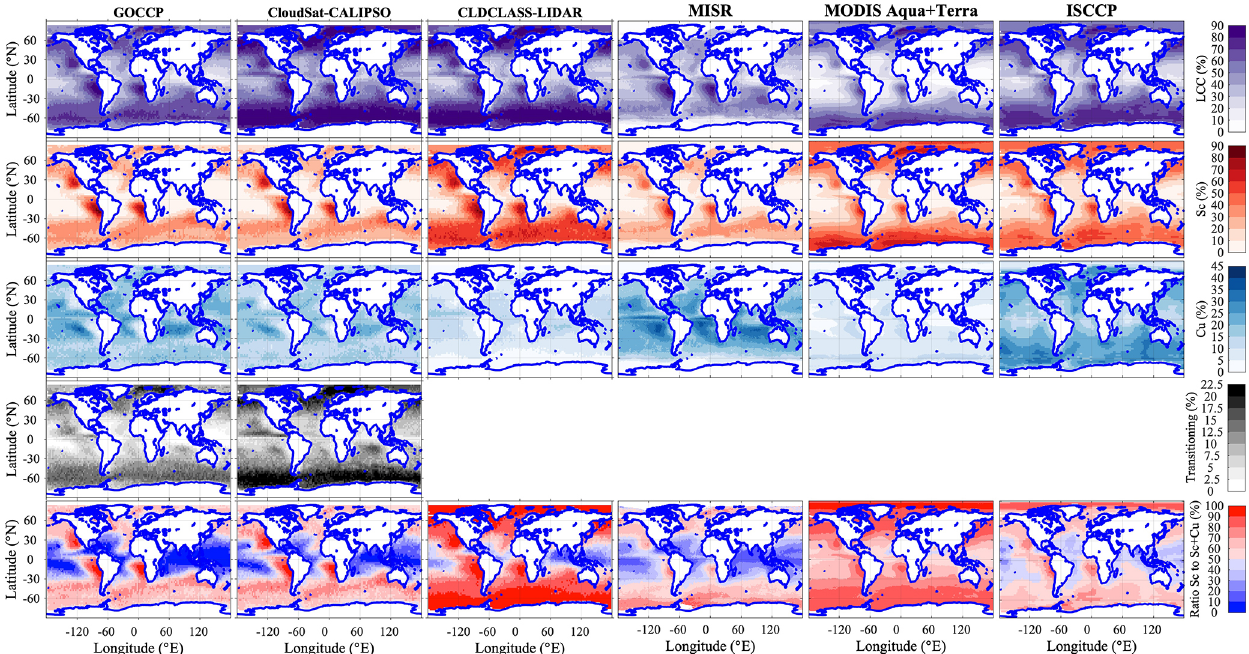
Figure 13. Maps ( x axis, longitude, ◦ E; y axis, latitude, ◦ N) of (top to bottom) low, Sc , Cu, transitioning (i.e., broken Sc, Cu under Sc and Cu with stratiform outflow), and the ratio Sc to Sc and Cu cloud fraction (%) for (left to right) GOCCP (2007–2016), RL-GeoProf (2007–2010), 2BCCL (2007–2010), MISR (2003–2012), MODIS Terra and Aqua (2003–2015) and ISCCP (1983–2008). Different color bars are used to better separate each type of cloud. Note that for active-sensor satellites, the low category accounts for all clouds present below 3.36km regardless of their cloud top height, hence the sum of Sc, Cu and transitioning cloud fraction can be smaller than the low cloud fraction. All datasets are averaged onto a 2.5 ◦ × 2.5 ◦